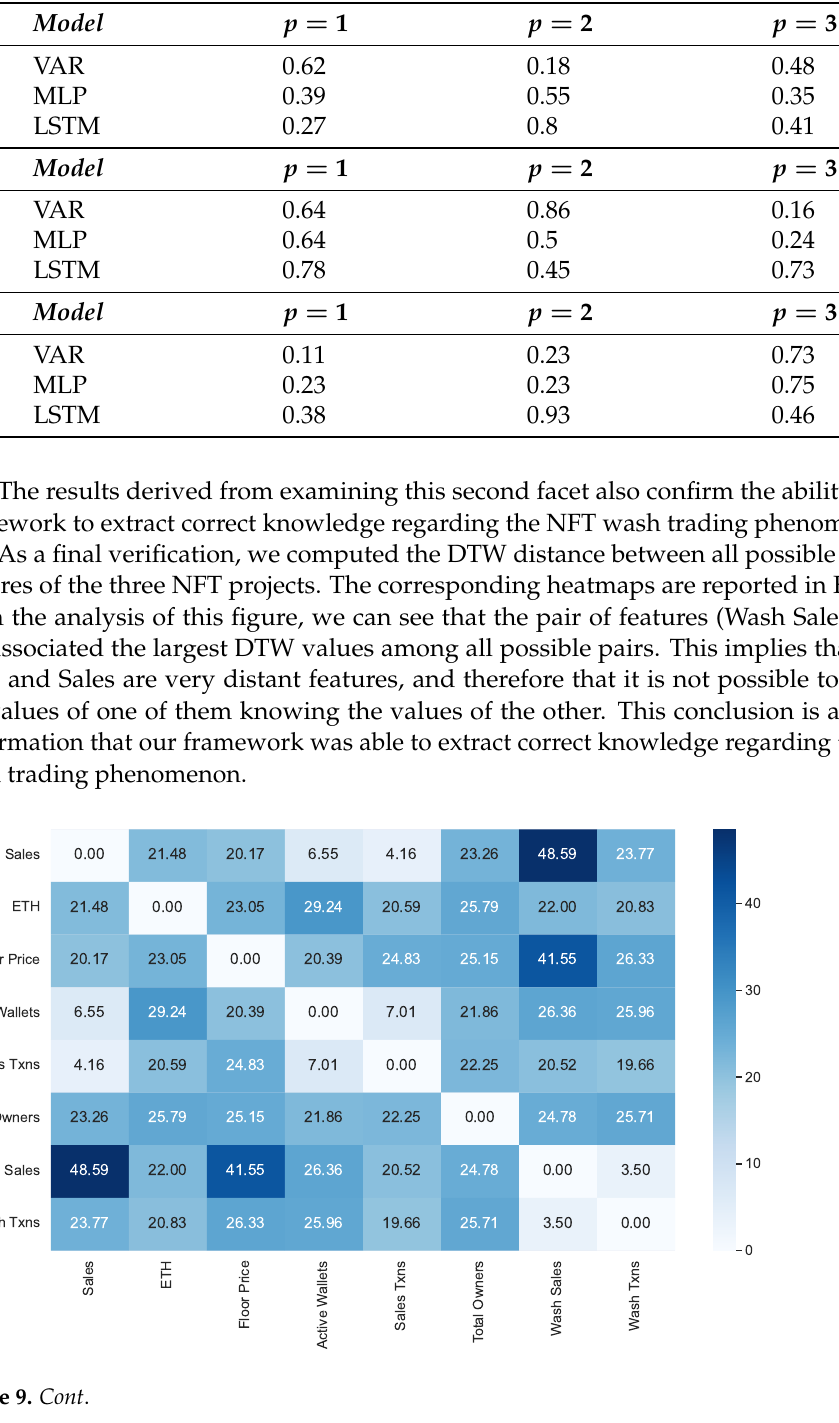
Table 2. p -values returned by the Granger tests applied on the features Wash Sales and Sales for Azuki, BAYC and Milady.